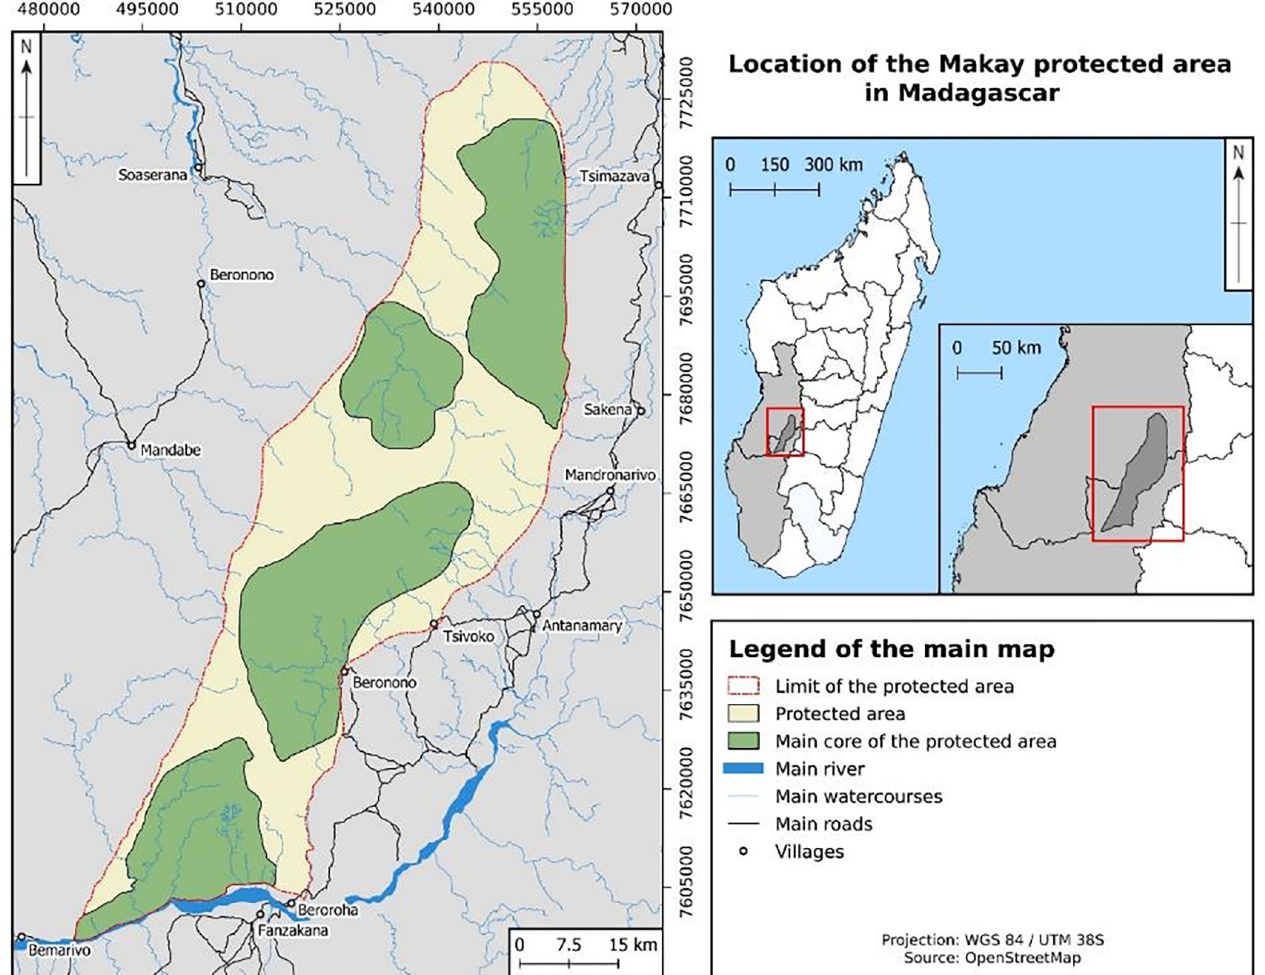
Fig 1. Location of the Makay region, Madagascar. The map was built by Aure´a Pottier (engineer at IRD), under QGIS, using OpenStreetMap data.